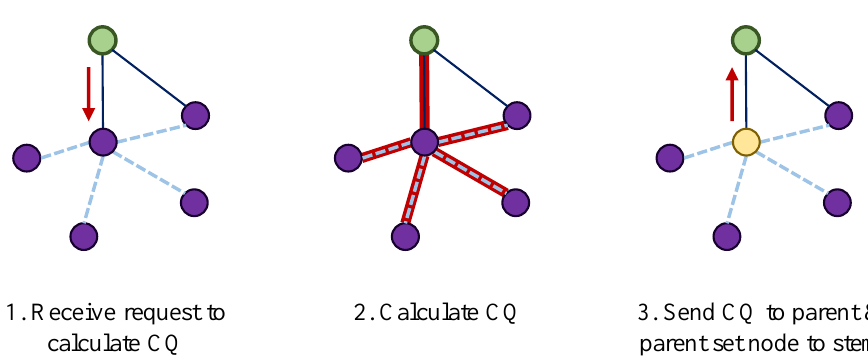
Figure 2. Sequence of connection quality calculation.